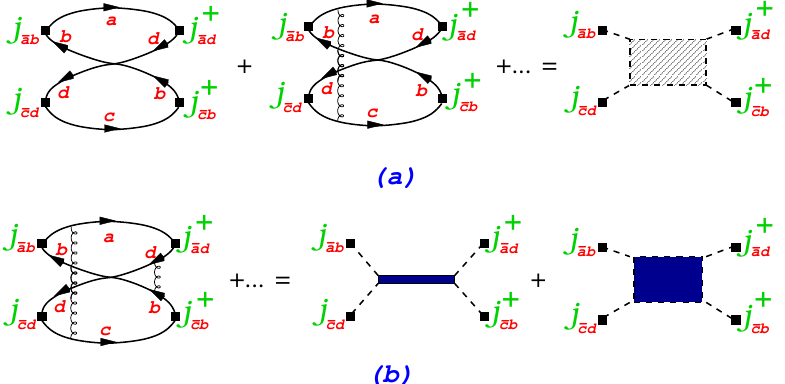
Figure 8. Outcome of application of established QCD sum-rule techniques to correlation func- tions (26), consisting of two uncorrelated quark–hadron relationships: ( a ) one equating the non- tetraquark-phile QCD contributions with hadron contributions not involving any two-meson s - channel cuts (subsumed by hatched rectangle); ( b ) the precursor of a tetraquark-adequate QCD sum rule, involving two-meson s -channel cuts (subsumed by a filled rectangle) and maybe tetraquark poles (blue horizontal bar) too